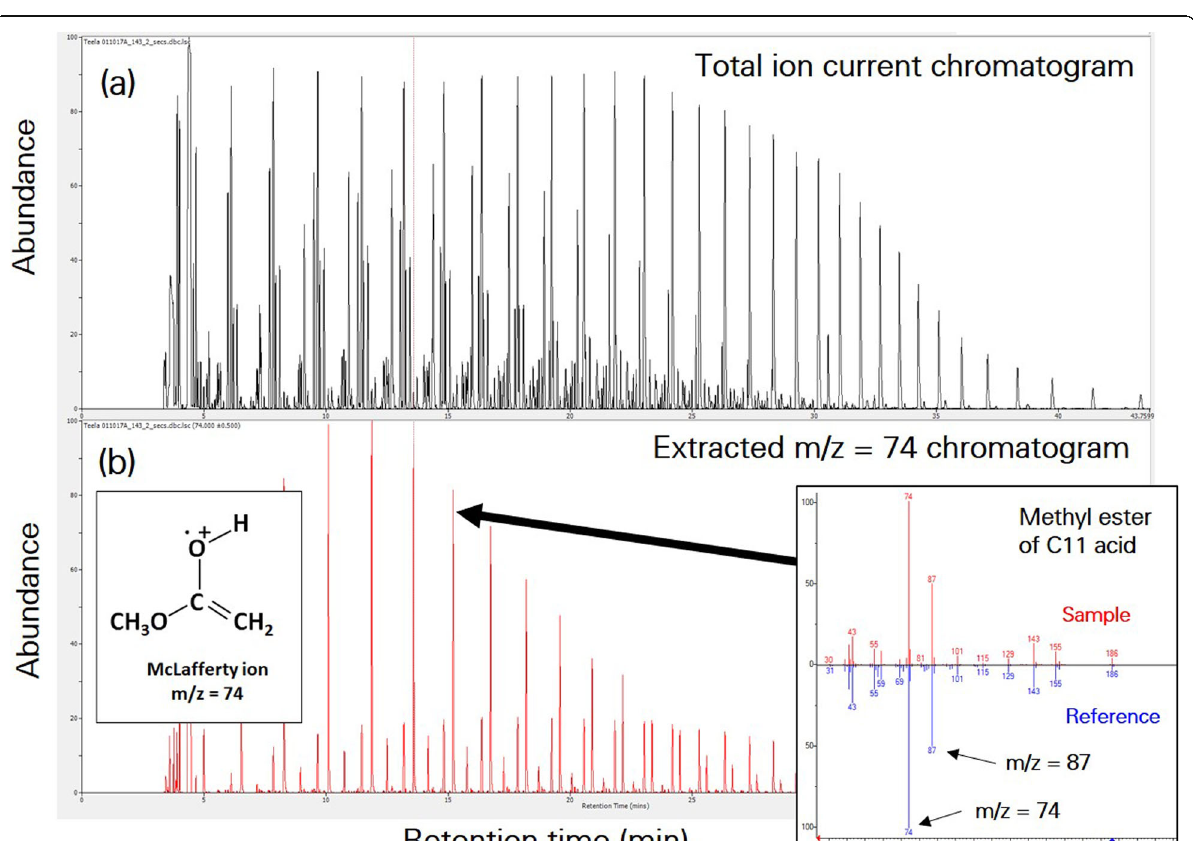
Fig. 6 GC-MS chromatogram of methyl esters of carboxylic